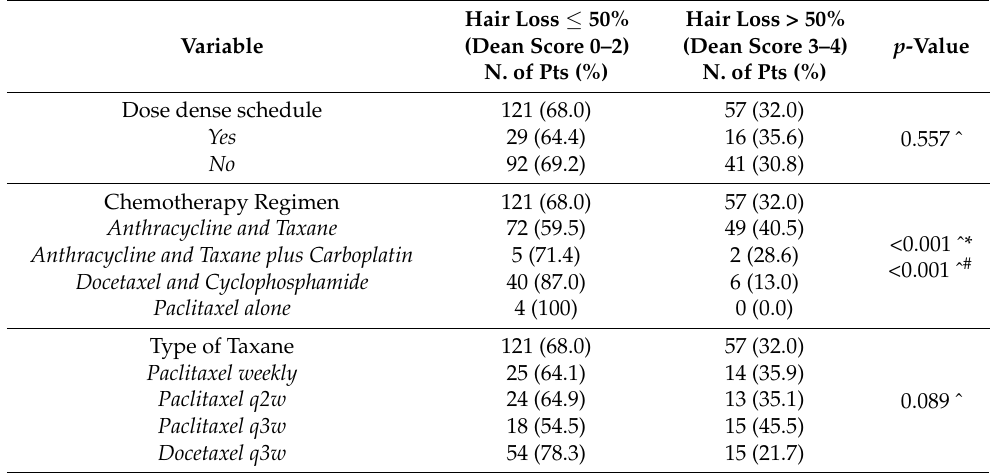
Table 3. The hair loss degree, evaluated by medical staff after the completion of all cycles of chemother- apy, according to the treatment characteristics.